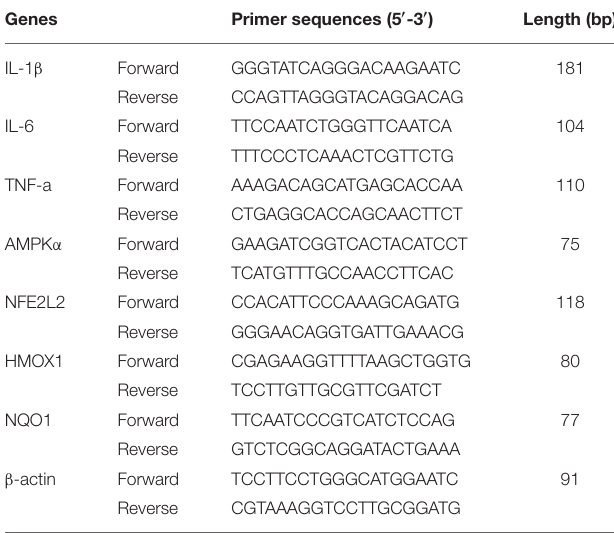
TABLE 2 | Primer sequences of the